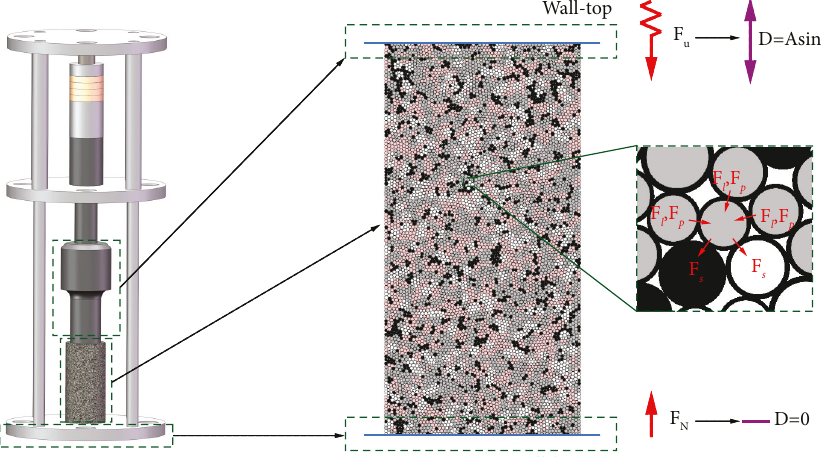
Figure 10: Model loading conditions corresponding to the